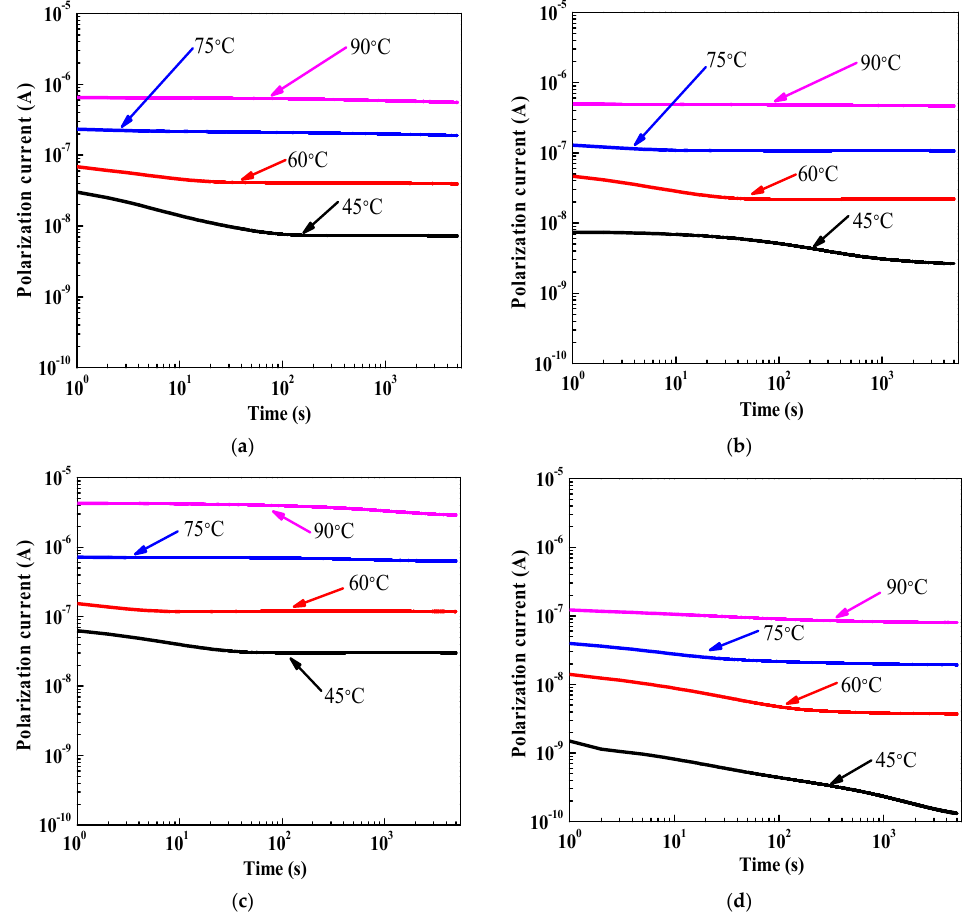
Figure 5. Measurment results of polarization current of oil-impregnated pressboard specimens with various insulation statuses. ( a ) Ageing 0 day (DP = 1285), moisture content 4.02%; ( b ) Ageing 8 days (DP = 994), moisture content 2.82%; ( c ) Ageing 21 days (DP = 841), moisture content 3.71%; and, ( d ) Ageing 42 days (DP = 415), moisture content 1.17%.